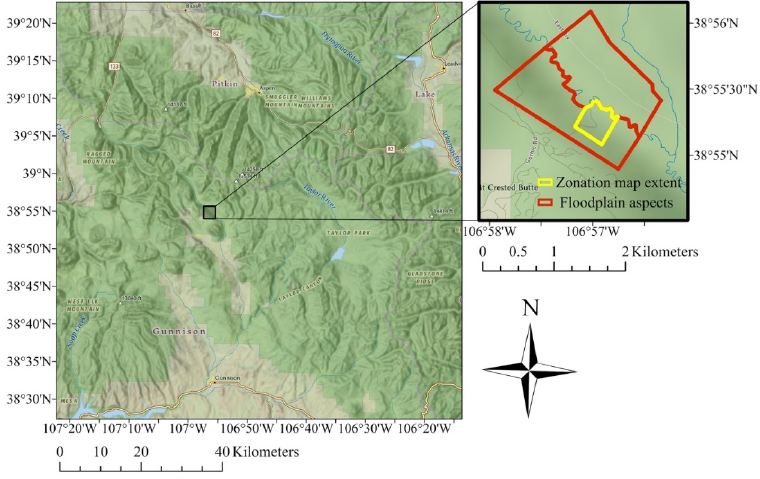
Figure 1. The study area location in the context of the surrounding Colorado Rocky Mountains region.